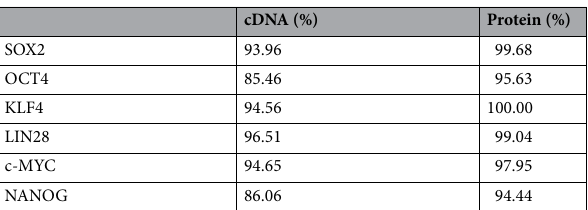
Table 1. Percentage of similarity between marmoset and rhesus macaque reprogramming factors on the cDNA and the protein level. Values are based on for the following sequences: SOX2